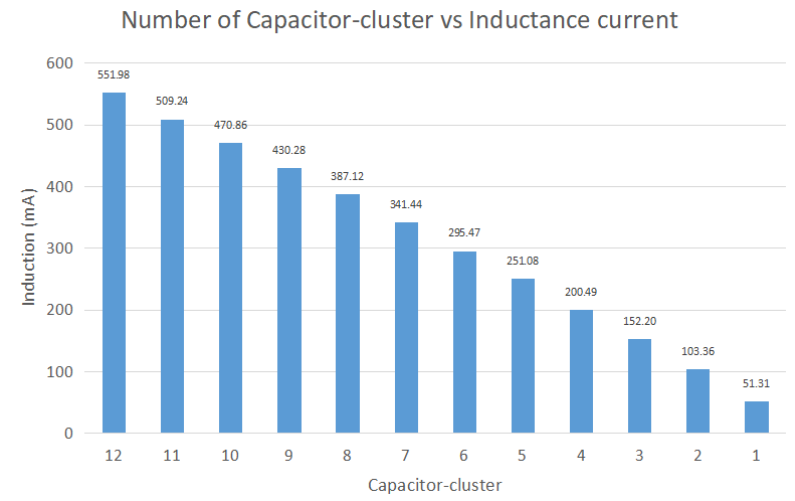
Figure 18. LTSPICE simulation result of capacitor-cluster vs. inductance current.